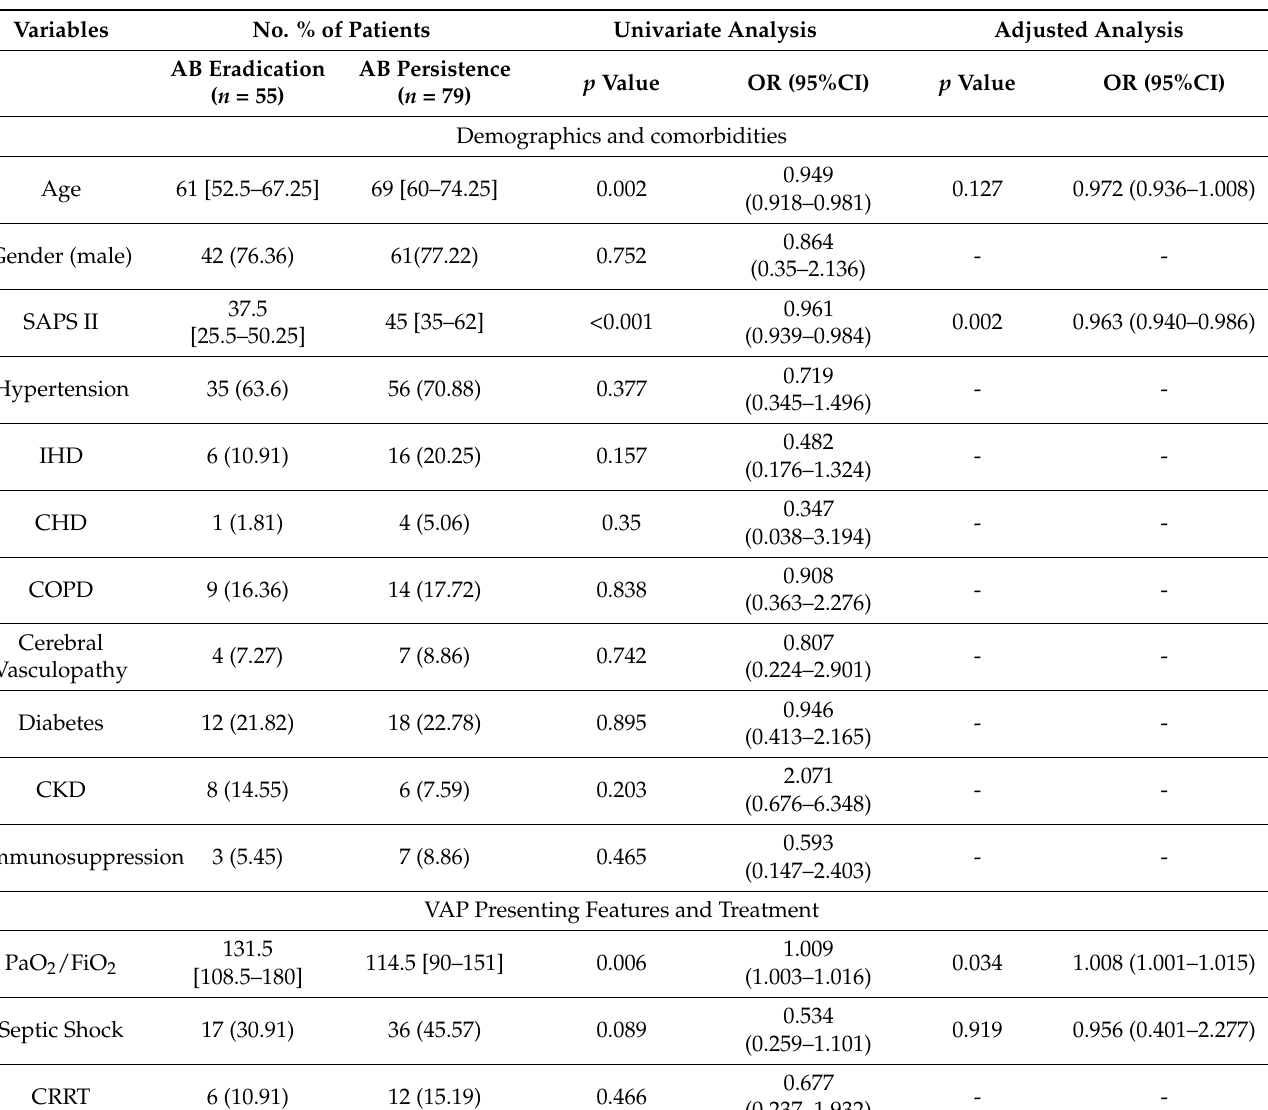
Table 2. Univariate and multivariate analysis of factors associated with AB microbiological